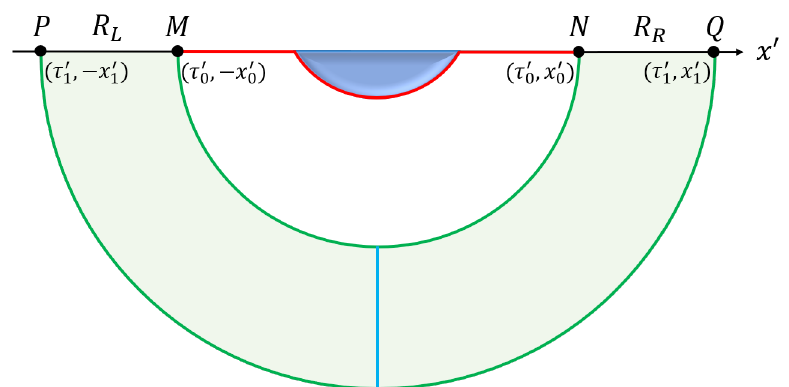
Figure 19. The connected phase viewed along z -axis. In this phase, the island is empty set. The reflected entropy between R L and R R is equal to the area of the entanglement wedge cross section, which is represented by the blue